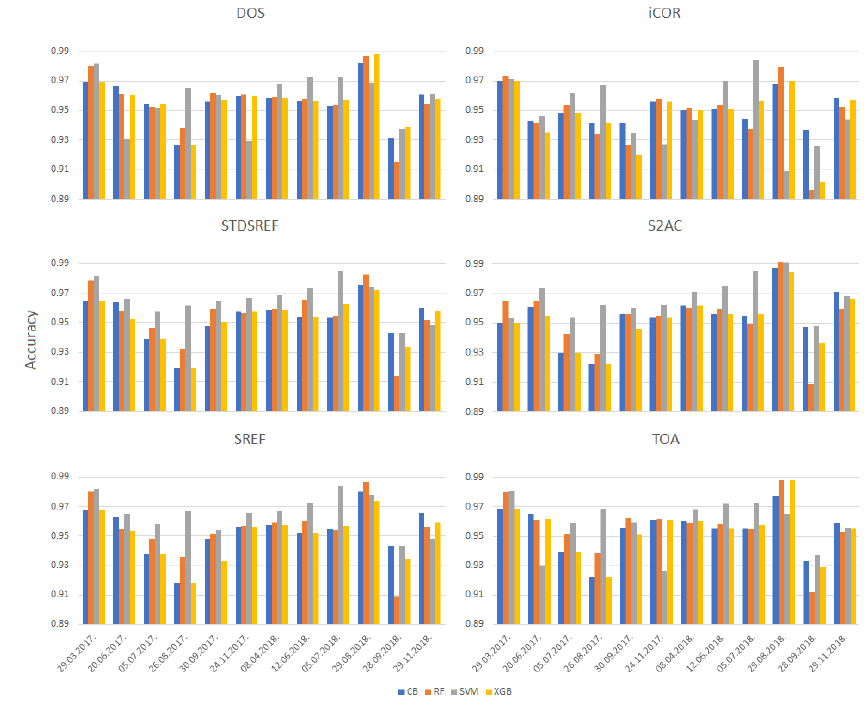
Figure 5. Classification accuracy based on atmospheric correction and date with radiometric indices. ISPRS Int. J. Geo-Inf. 2020 , 9 , x FOR PEER REVIEW